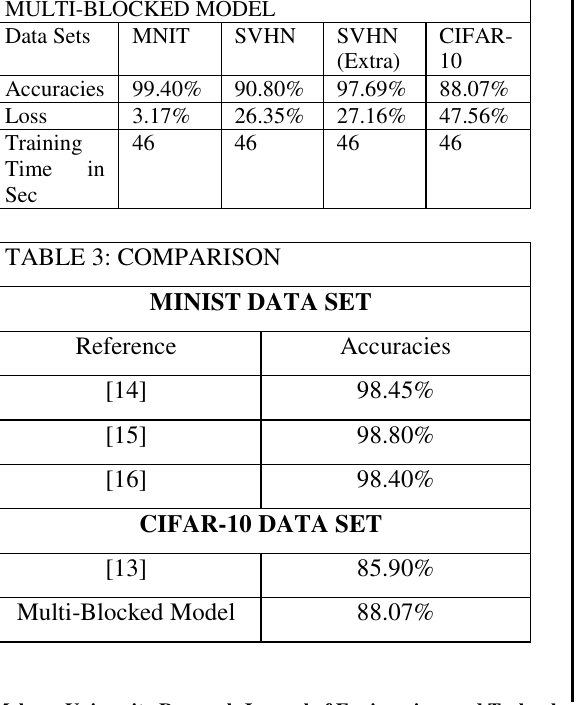
Fig. 6: Loss of MNIST AND CIFAR-10 Data Sets TABLE 2: SUMMARY OF THE PERFORMNCE OF MULTI-BLOCKED MODEL